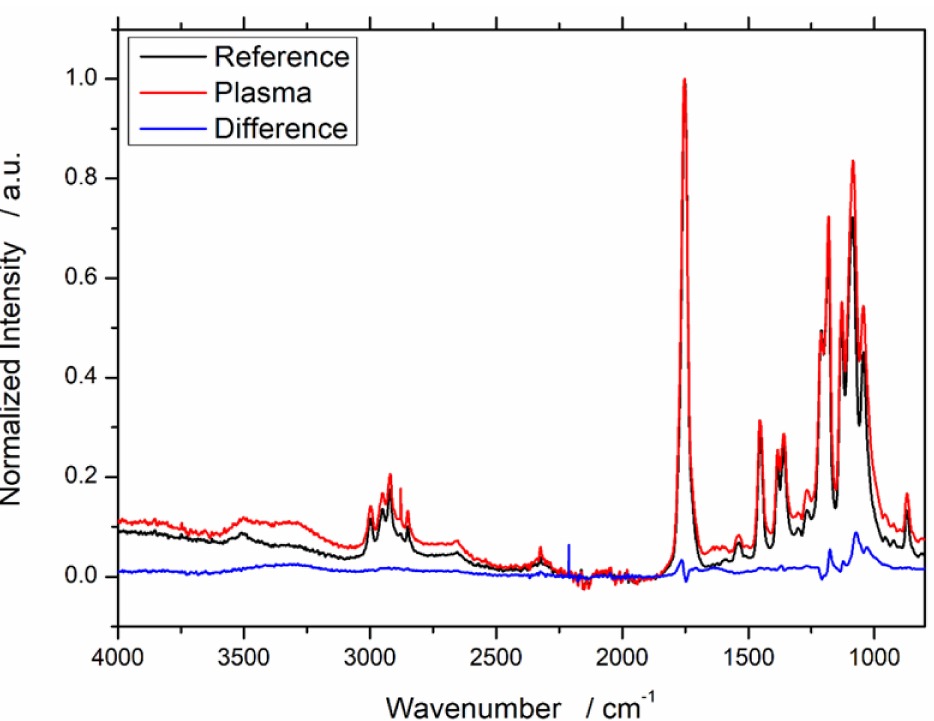
Figure 1. FTIR spectra of WPC with 60% wood content in PLA before and after plasma treatment. Measured spectra are normalized on the max peak (reference = 1752 cm − 1 ; plasma-treated = 1753 cm − 1 ), and a difference spectrum is calculated (blue line).